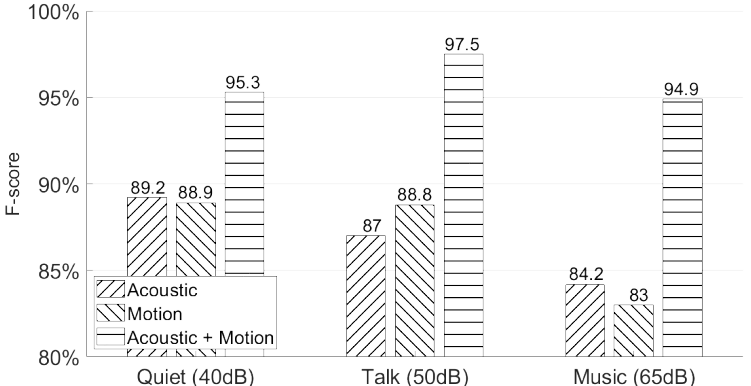
Figure 17. Different environments’ authentication performances—quiet, talking, and